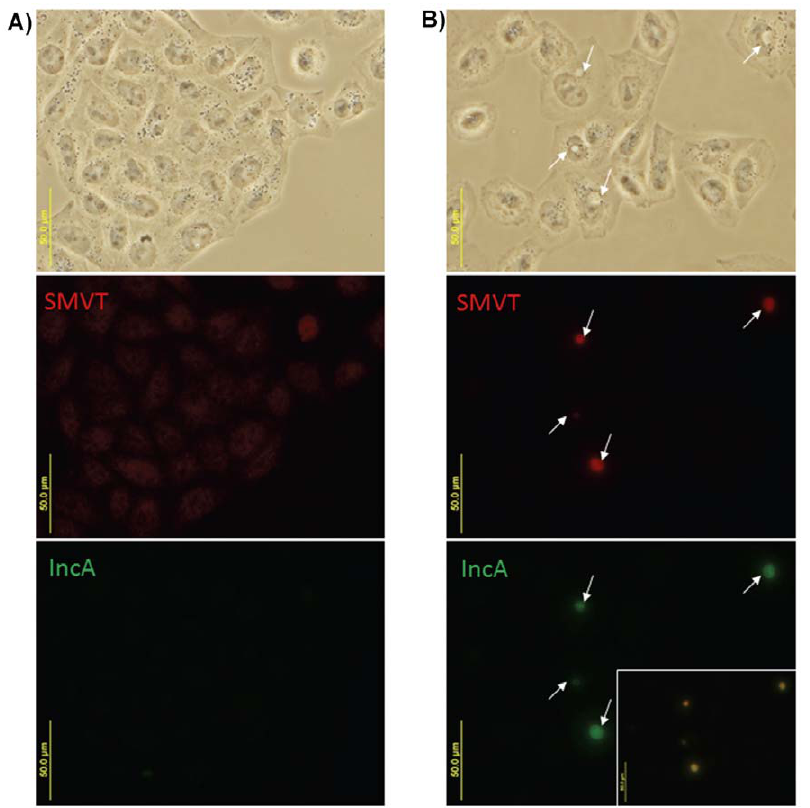
Figure 6. Localization of SMVT in infected HeLa cells using immunofluorescence microscopy. HeLa cells were mock infected (A) or infected with C. trachomatis 434/Bu (B) for 20–24 hours, fixed and permeablized, and probed with anti-IncA antibodies (shown in green) and anti- SMVT (H56) antibodies (shown in red). The location of inclusions viewed under phase contrast (top panel) and fluorescence (middle and bottom panels) are shown with white arrows. The inset in panel (B) was created by merging the red and green channel micrographs.